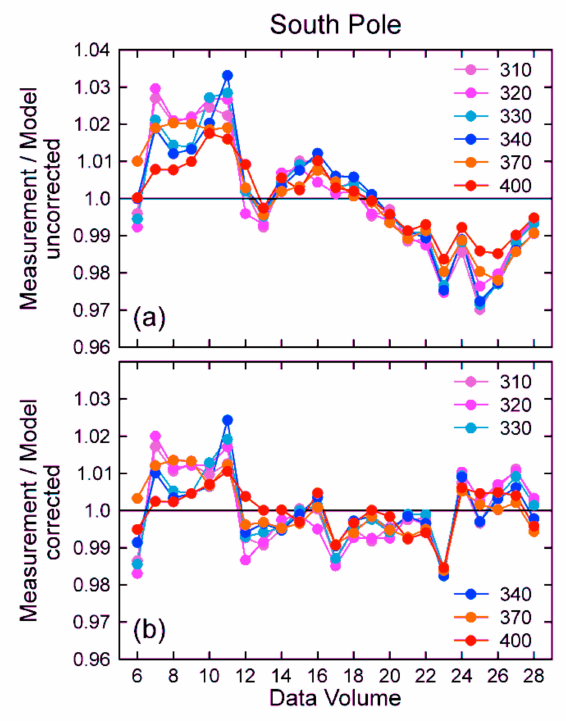
Figure 1. Normalized median ratios of measurement and model at 300, 320, 330, 340, 370, and 400 nm at South Pole: ( a ) Median ratios calculated from published spectra. Panel; ( b ) Median ratios corrected for changes in the SoSI described in Sections 2.4 and